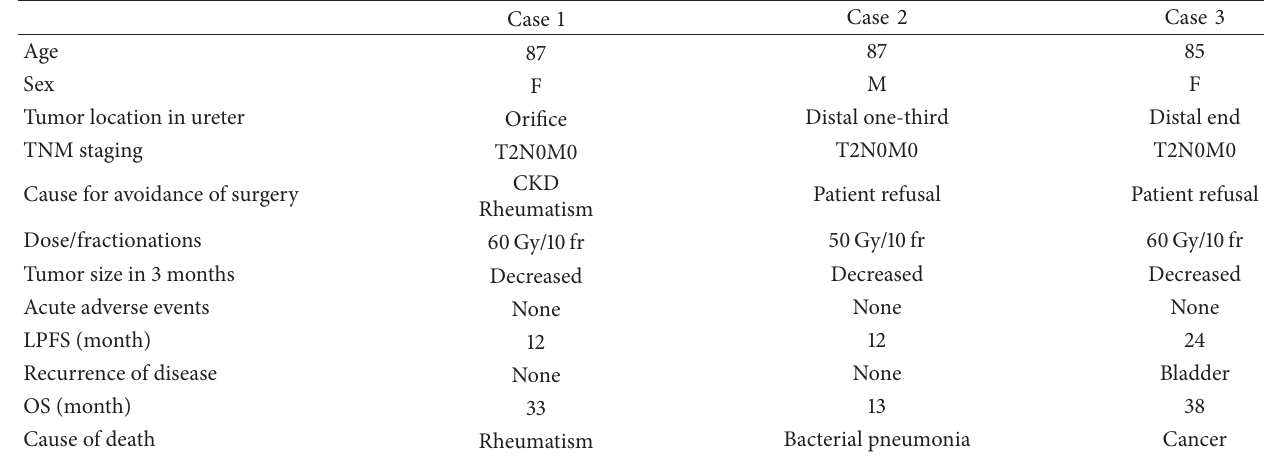
Figure 3: Contrast-enhanced CT scan of the patient. (a) A CT scan showed the tumor as enhanced thickness of the wall at the distal ends of the left ureter before the treatment (see arrow). (b) The enhanced thickness of the ureteral wall improved 3 months after SBRT. Table 1: Summary of case